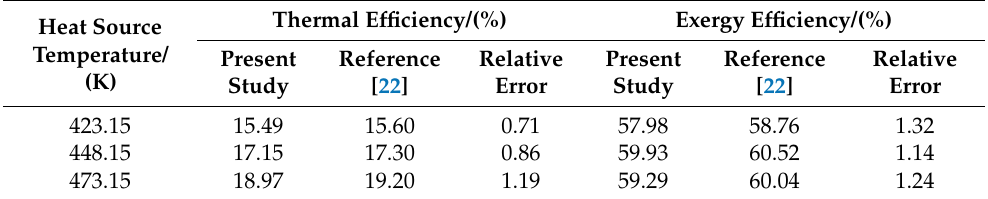
Table 3. Comparison between the results of this paper and the results of the